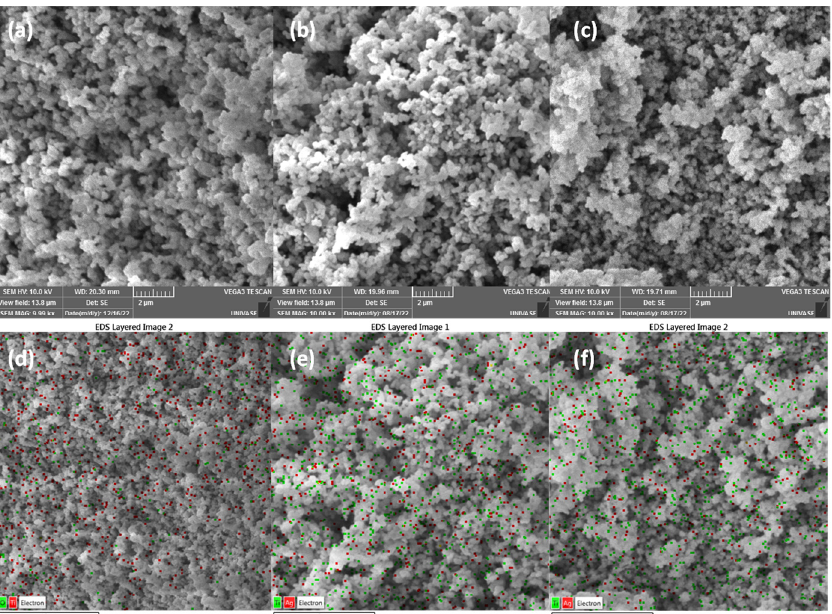
Ag/TiO 2 con fi rm the presence of elements Ti (red dots) and O (green dots)—Figure 1d— and Ti (green dots) and Ag (red dots) in Figure 1e,f for samples 2% Ag/TiO 2 and 10% Ag/TiO 2 , respectively.